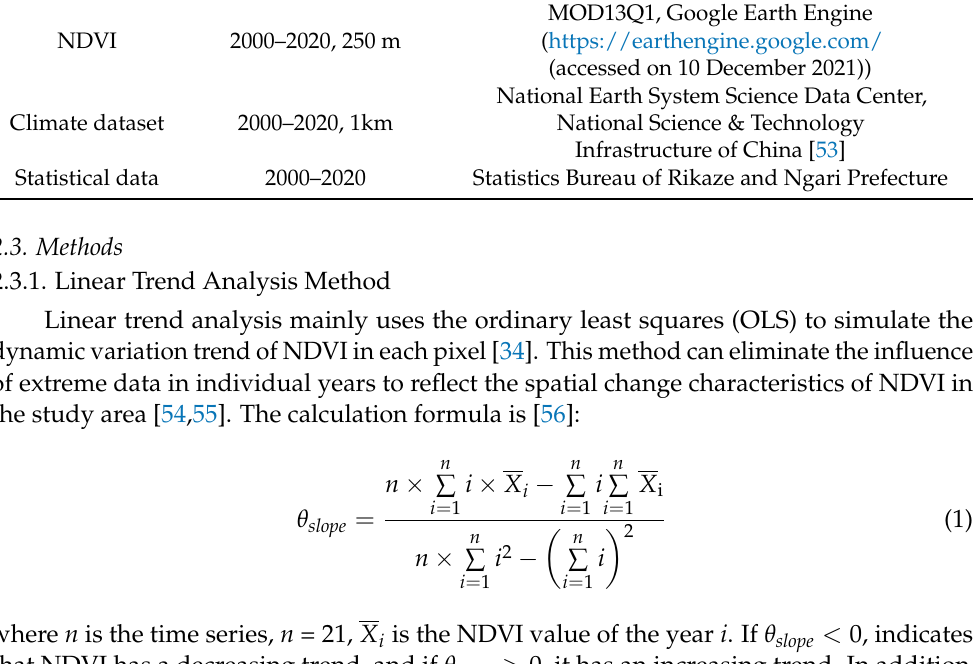
Table 1. Sources of the fundamental data used. Dataset Time and Spatial